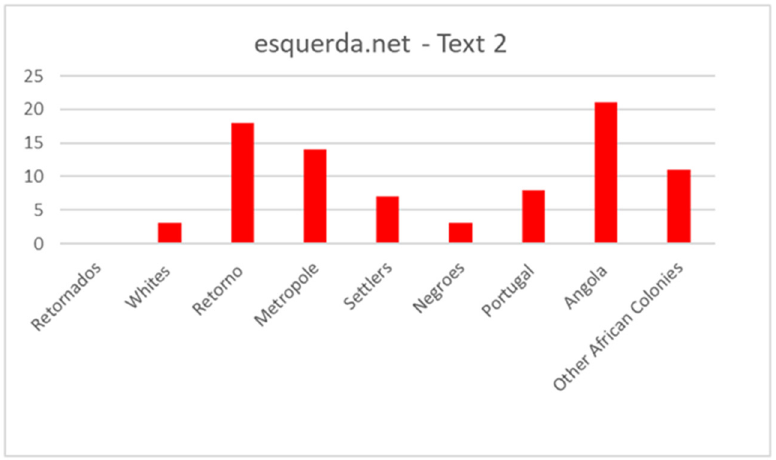
Figure 7. Most recurrent words in the article “15 de março de 1961: A UPA e a revolta no norte de Angola”. Source: esquerda.net (2018) [22].